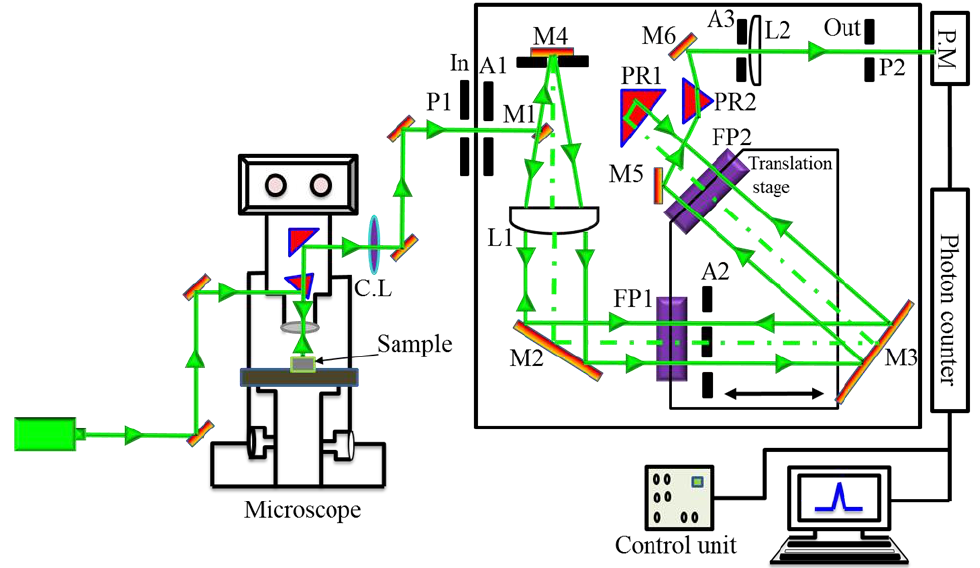
Figure 2. A schematic illustration of micro-Brillouin scattering setup.